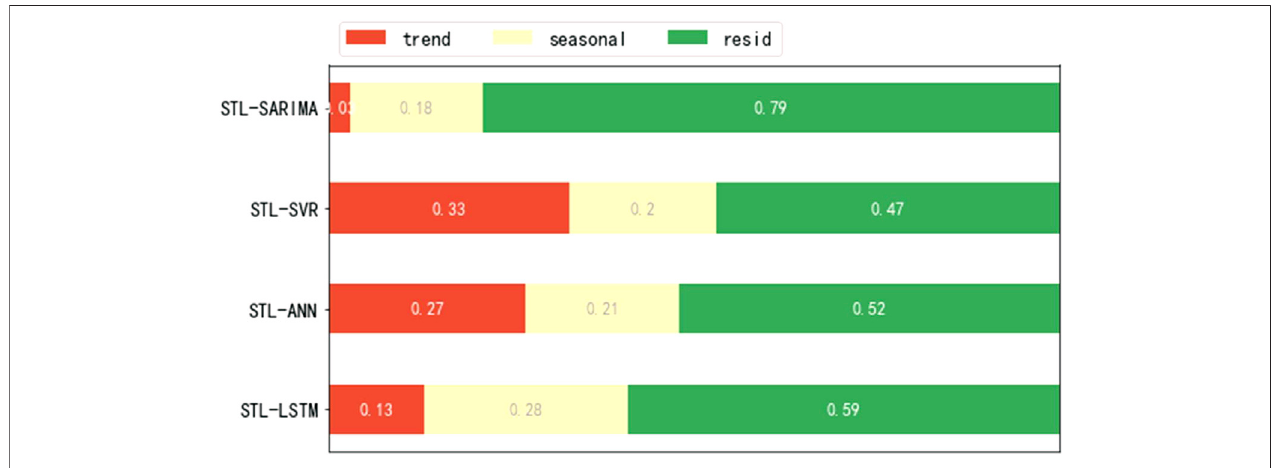
FIGURE 5 | Trend, season, random error ratio.